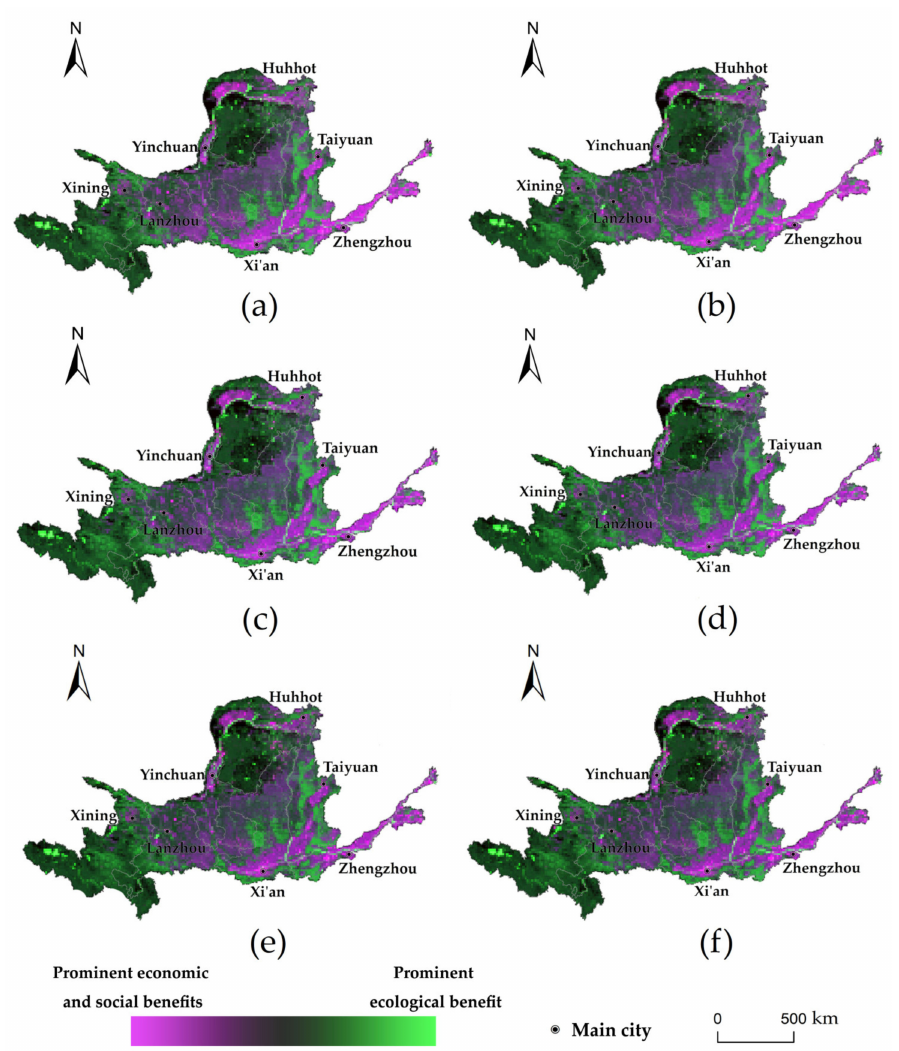
Figure 8. The superposition of economic, social and ecological benefits of land use in the Yellow River Basin: ( a ) 1995; ( b ) 2000; ( c ) 2005; ( d ) 2010; ( e ) 2015; ( f )